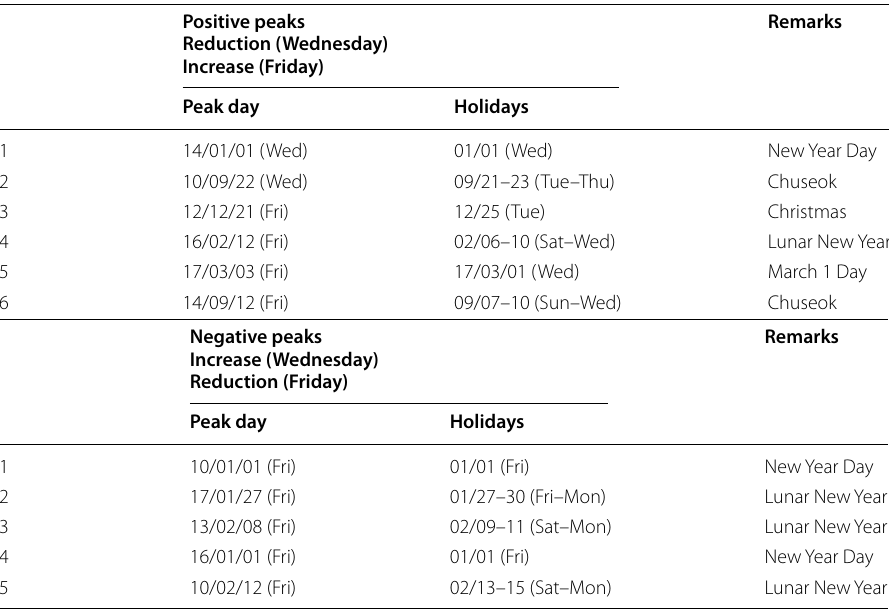
Table 4 Day (of the week) of the major peaks in the PC time series of the third CSEOF mode and the linked